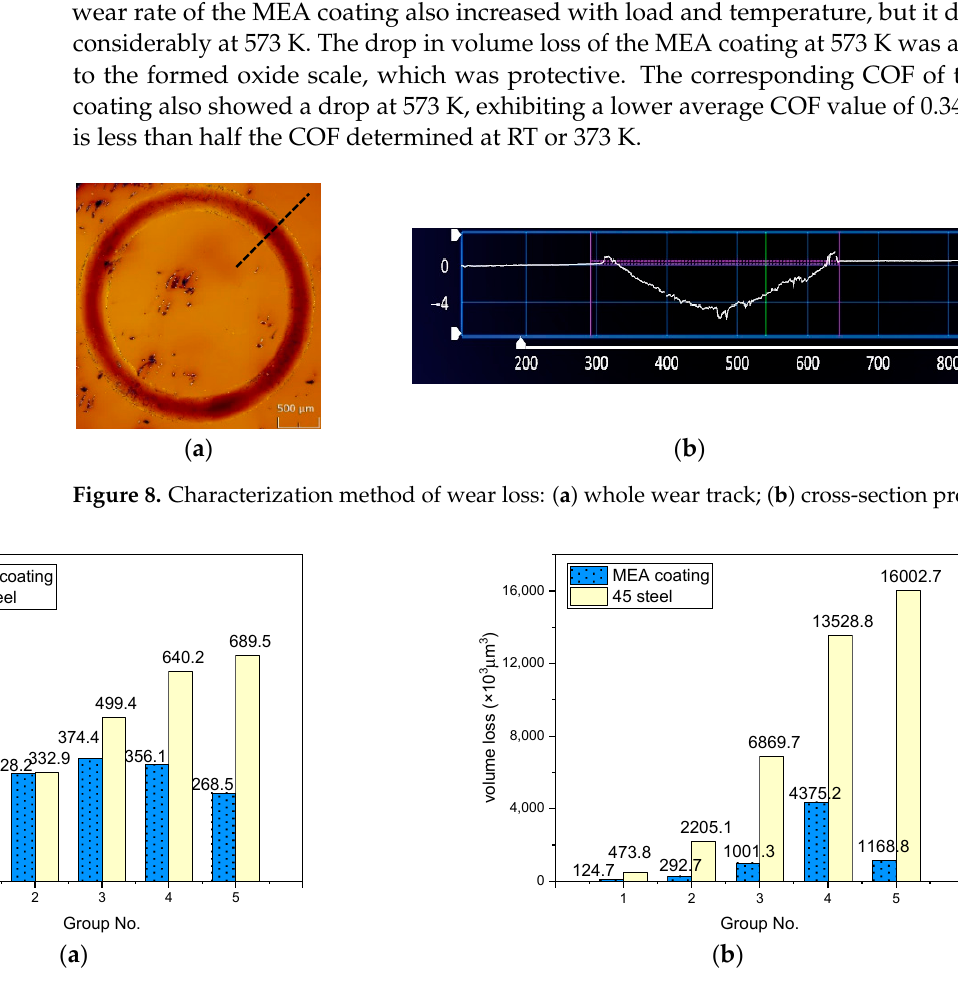
Figure 7. Wear track of Fe 6 CoCrNiAl coating: ( a ) 1 N, RT; ( b ) 5 N, RT; ( c ) 10 N, RT; ( d ) 10 N, 373 K;